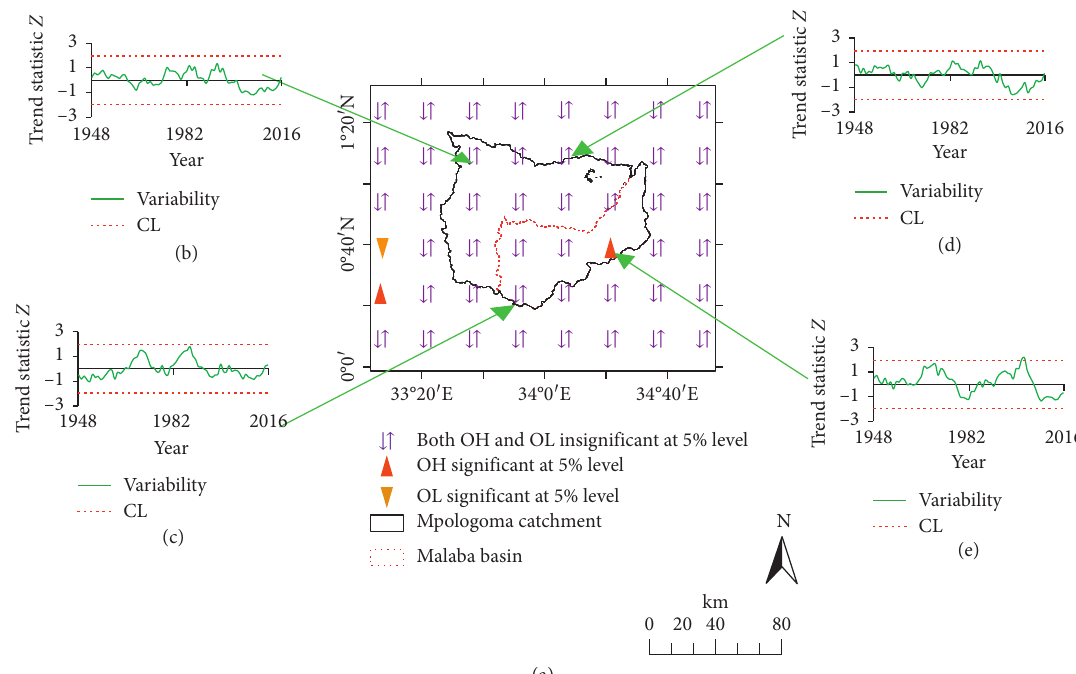
Figure 9: Spatial differences in the significance of evapotranspiration variability (a) and temporal variability (b–e) in JJAS evapotrans- piration at different locations of the study